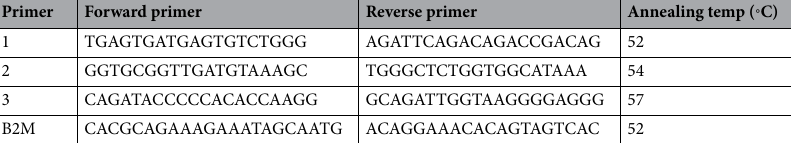
Table 2. List of primers for sequence specific amplification of AChE gene.